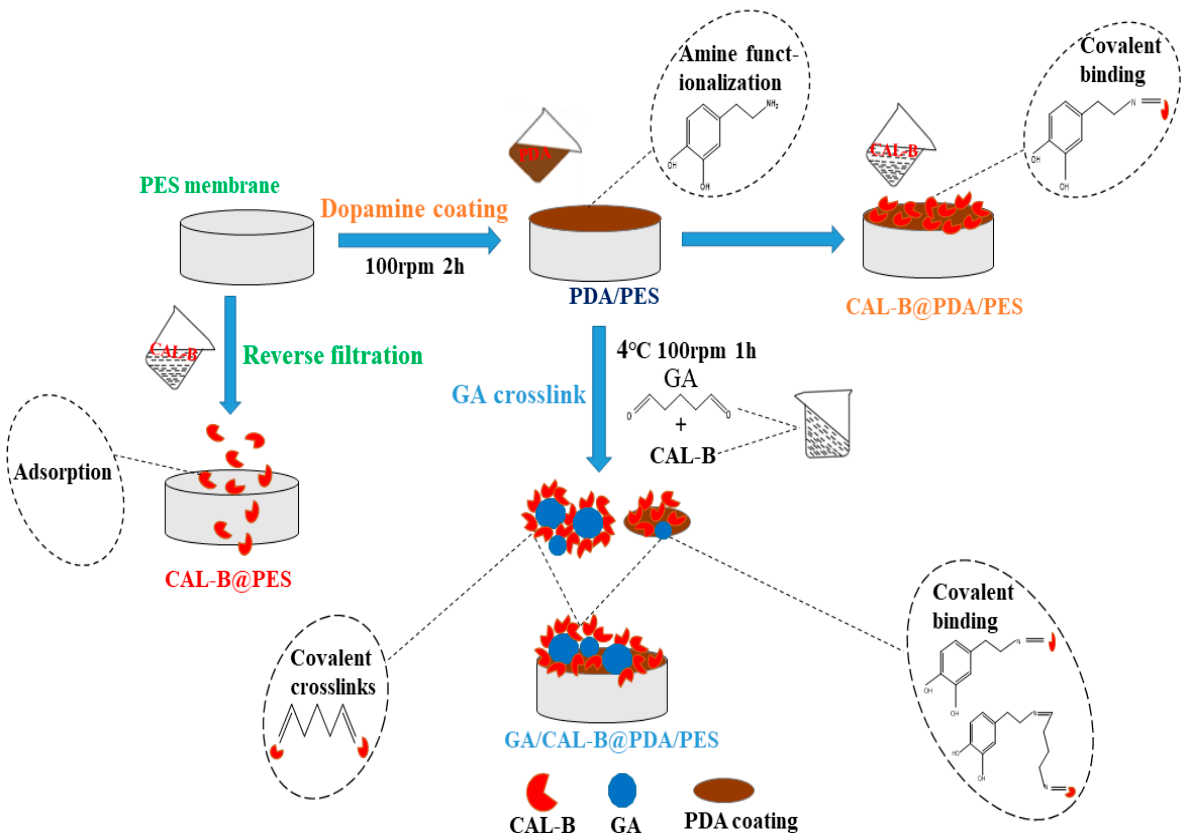
Figure 1. Schematic diagram for BLIMs’ fabrication.